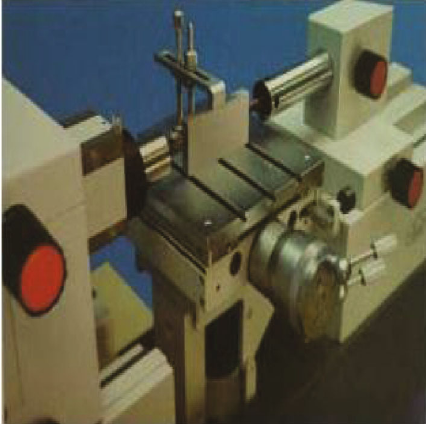
Figure 2: Length measuring instrument.